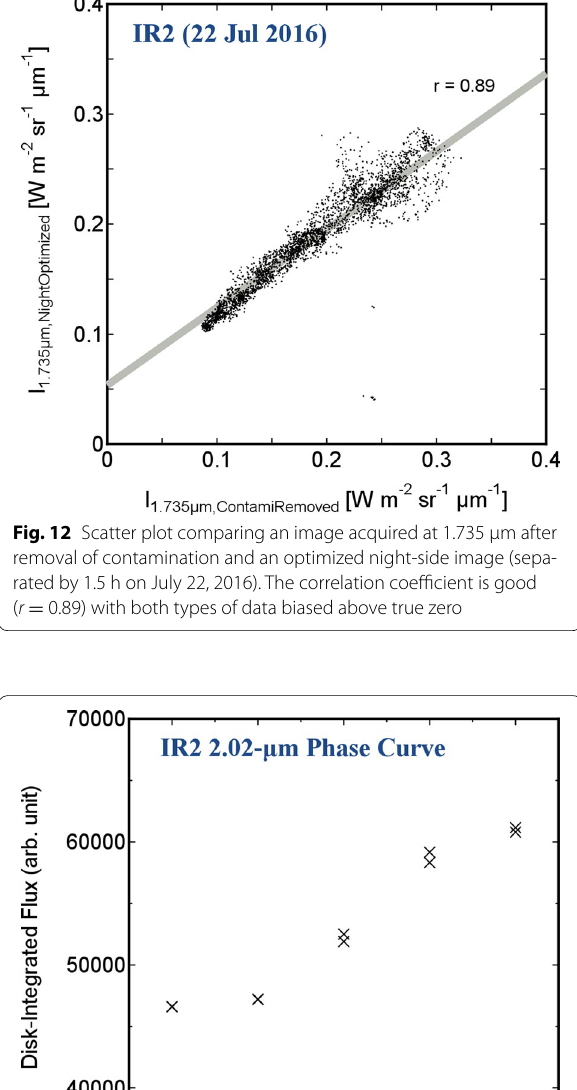
(1.735, 2.26, and 2.32 μm) images of Venus were obtained.